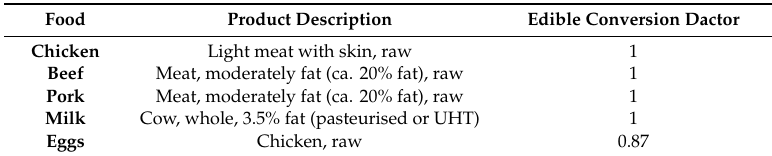
Table 2. Description of food products used for comparison to the sampled species and their edible product conversion factors a